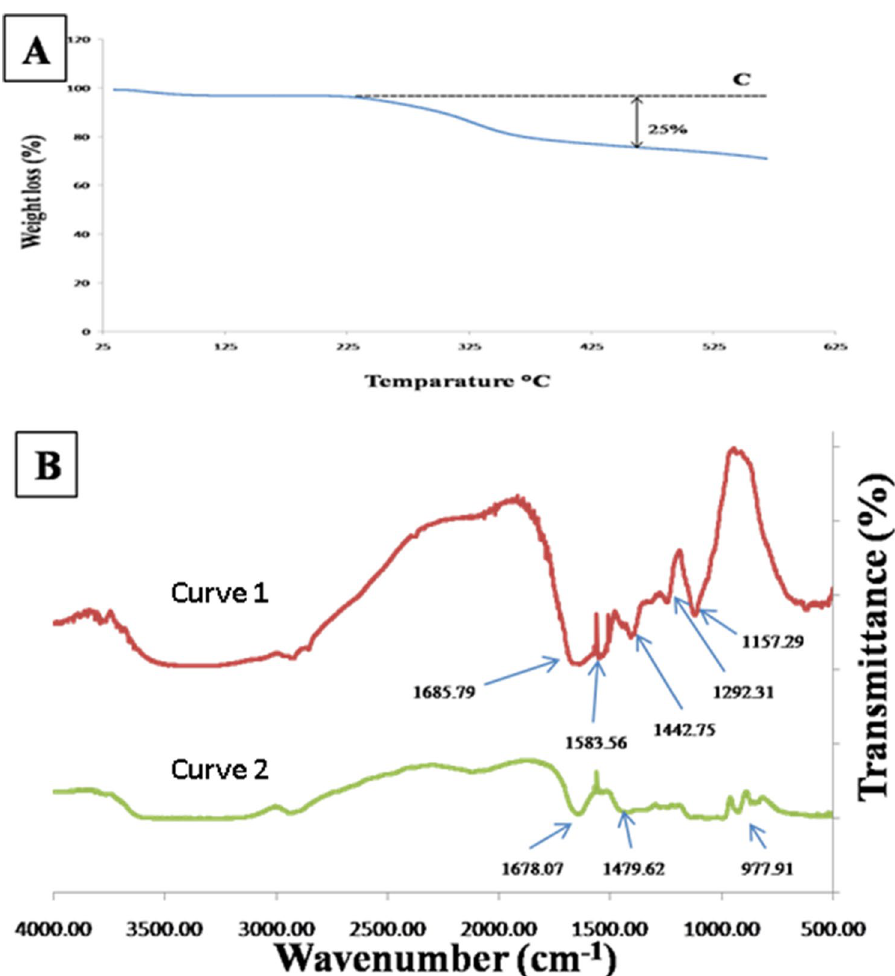
Figure 6. ( A ) TGA spectra of the synthesized prismatic gold nanozymes where C is the baseline ( B ) FTIR spectra of aqueous fraction (AF) of Carica papaya L. (curve 1) latex and synthesized gold nanozymes with 1 mM HAuCl4 (curve